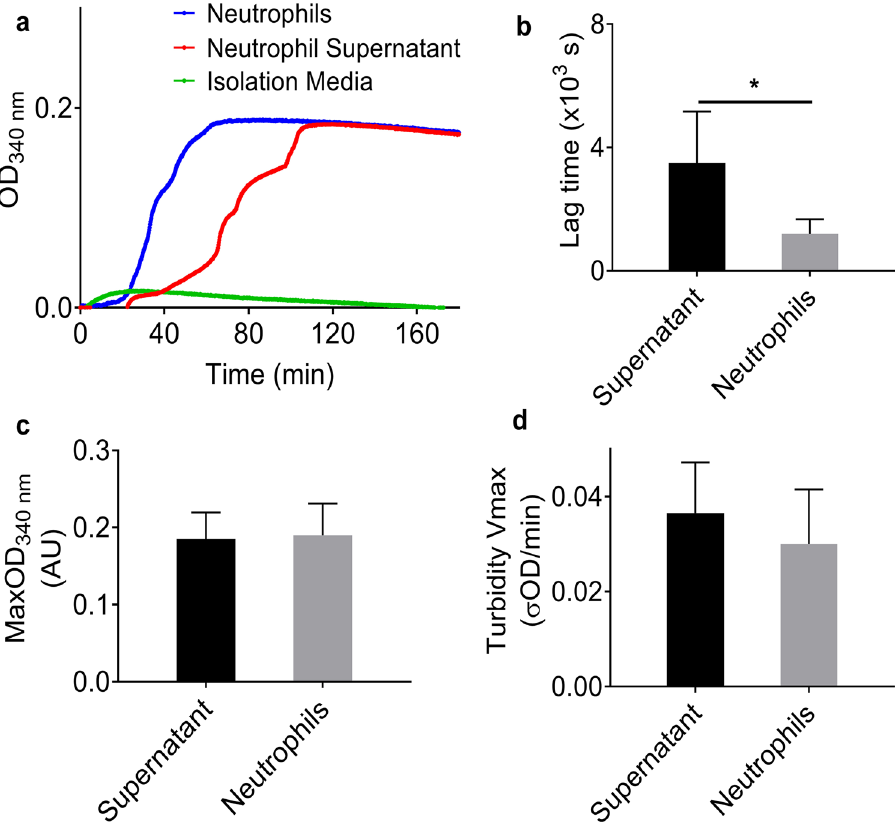
Figure 3. Effects of human neutrophil supernatant on clot formation. ( a ) Clot polymerization curves, obtained by turbidity, showing the effects of human neutrophils (200,000 cells/100 µl) and their supernatant on clot formation when added to NPP. ( b ) Lag time, ( c ) MaxOD and ( d ) maximum rate of clot formation (turbidity Vmax) were quantified. Other concentrations: plasma (diluted 1:6) and CaCl 2 (3.33 mM). Error bars represent SD of 5–6 replicates. * P < 0.05.